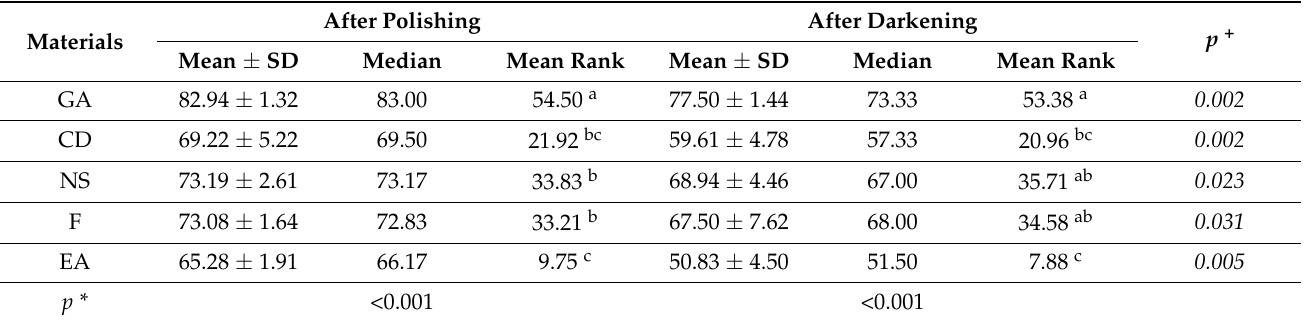
Table 2. Mean, SD, and median of gloss values (gloss units/GU) of the tested CRs.